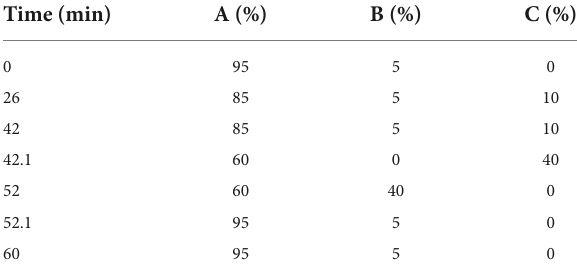
TABLE 1 Gradient program for high performance anion exchange chromatography